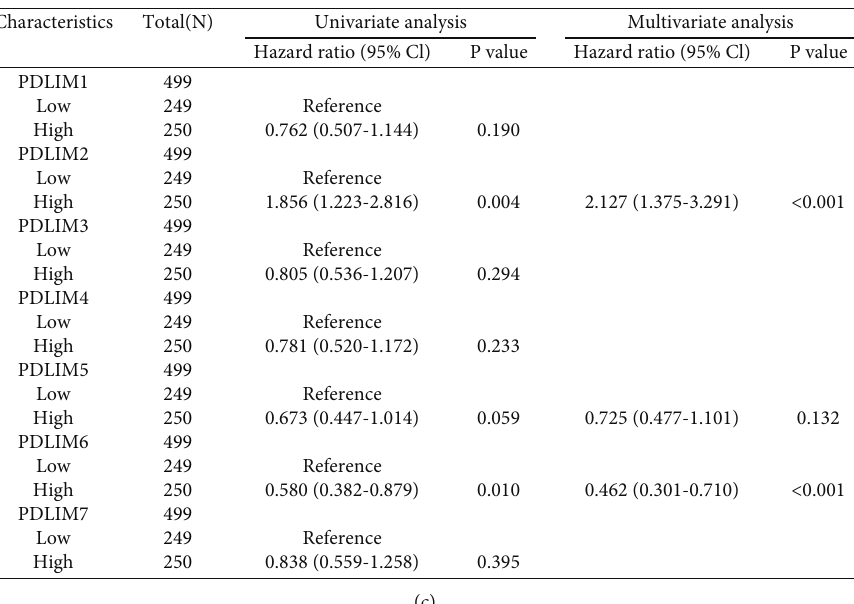
Figure 2: High-PDLIM2 expression was an independent predictor of poor prognosis in prostate cancer. (a, b) Kaplan – Meier survival plots of overall survival (OS) and progression free interval (PFI). (c) Univariate and multivariate Cox proportional analyses for